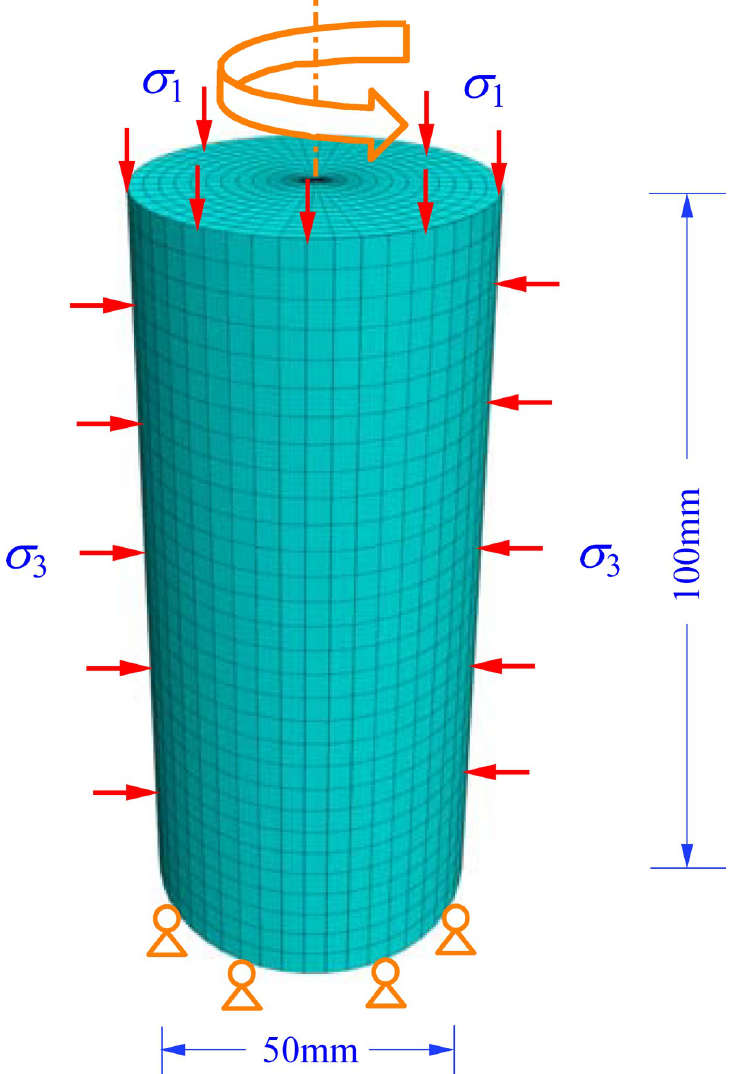
Fig 9. Numerical model and boundary